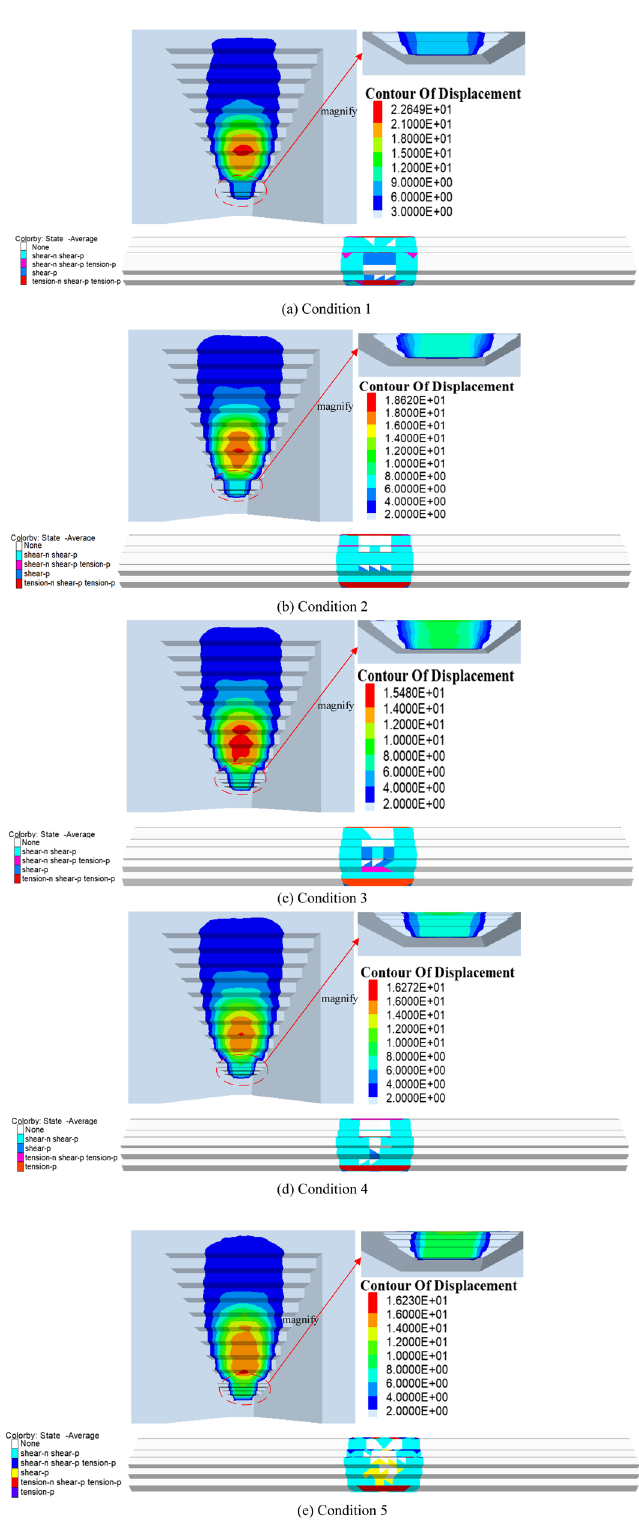
Fig. 14 Distribution of displace- ment and plastic